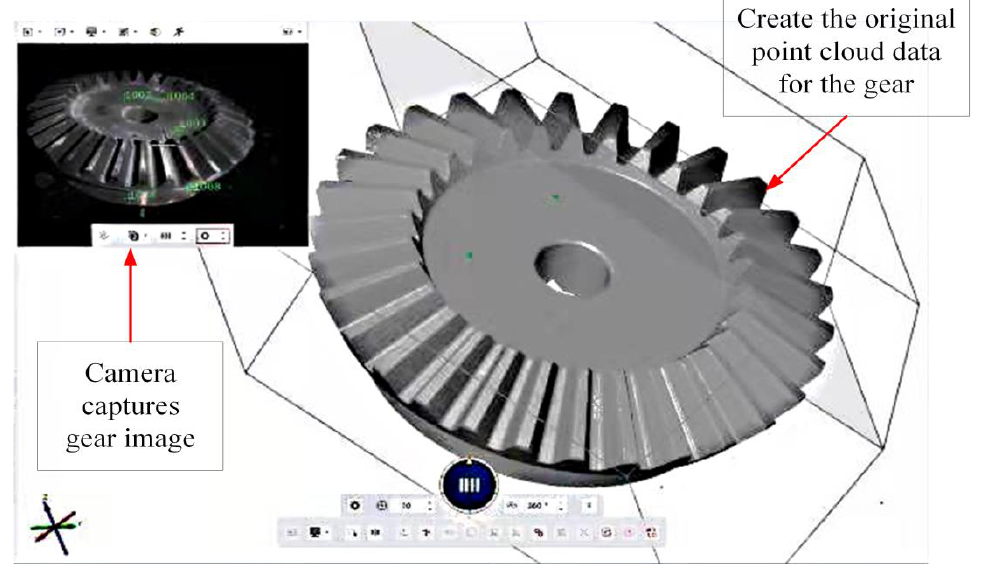
Figure 10. Collected gear point clouds.